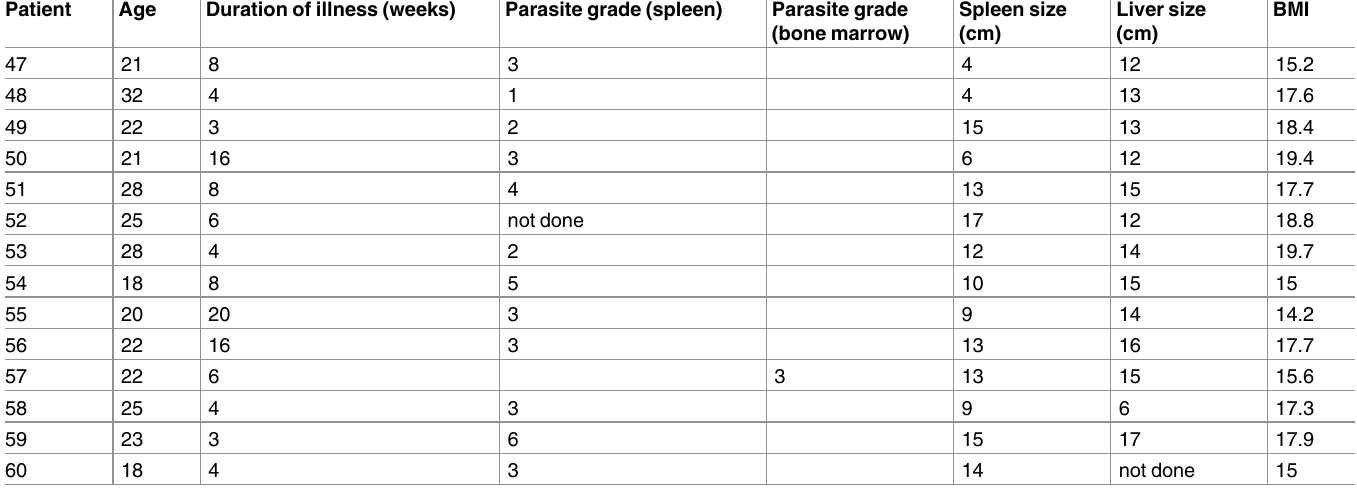
enlarged abdomen (as a sign of enlarged spleen or